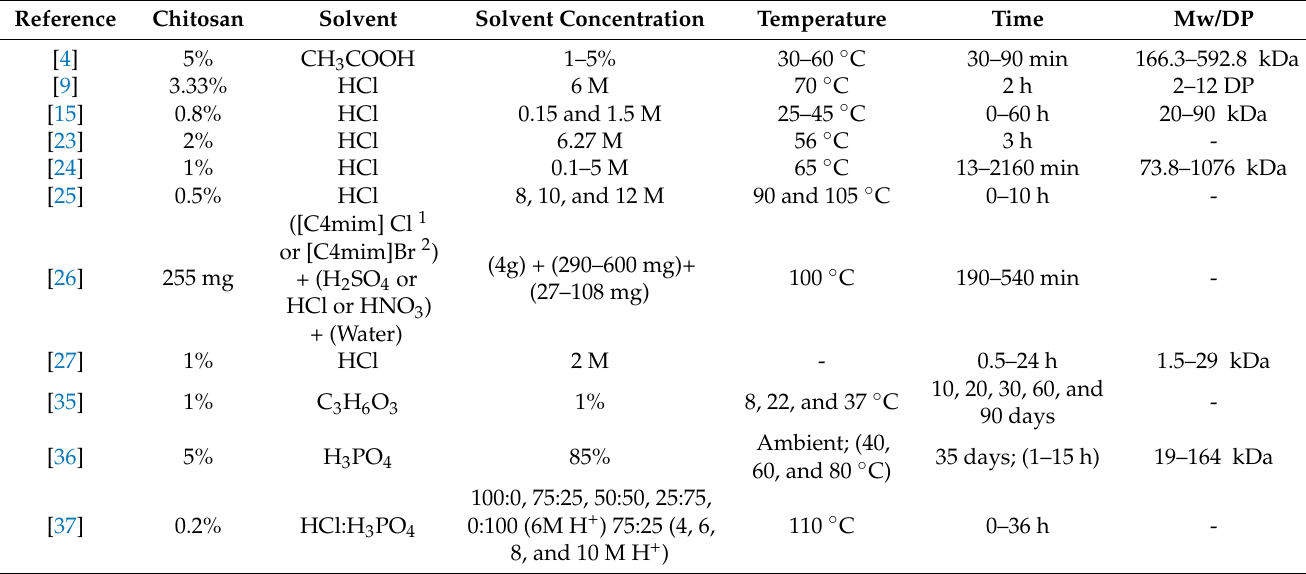
Table 1. Parameters for chitosan acid